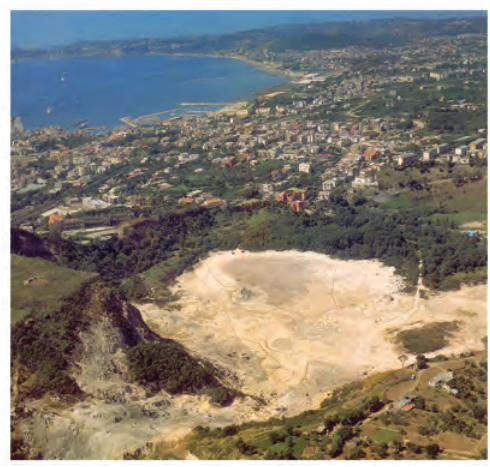
Fig. 3. Solfatara crater at Pozzuoli (Naples, Italy). Picture from «Pozzuoli dal cielo» by Aeromap